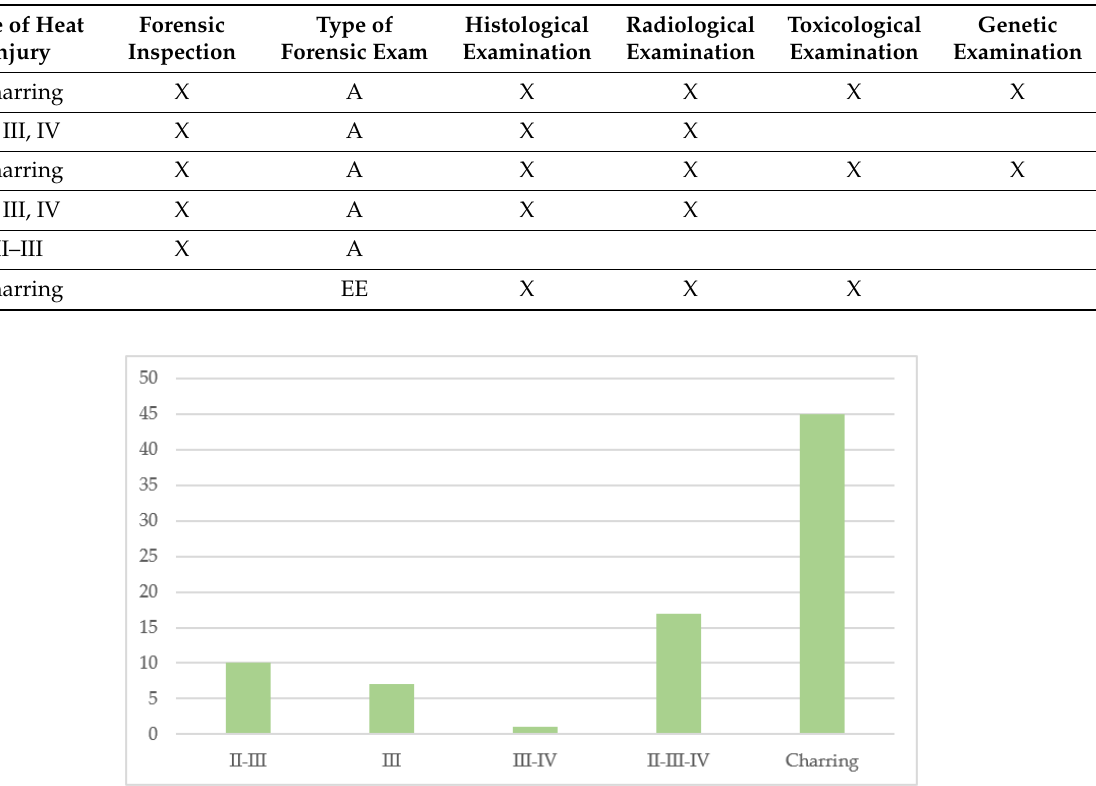
Figure 3. The graph shows the number of subjects who were found charred or with different degrees of burns (II–III; III; III–IV; II–III–IV).